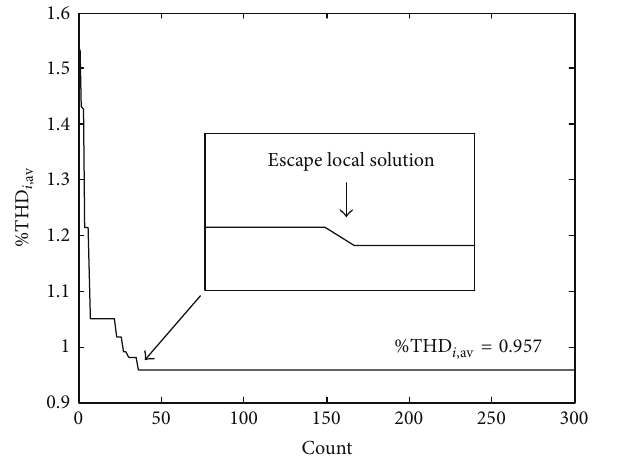
Figure 22: The convergence of the %THD 𝑖,